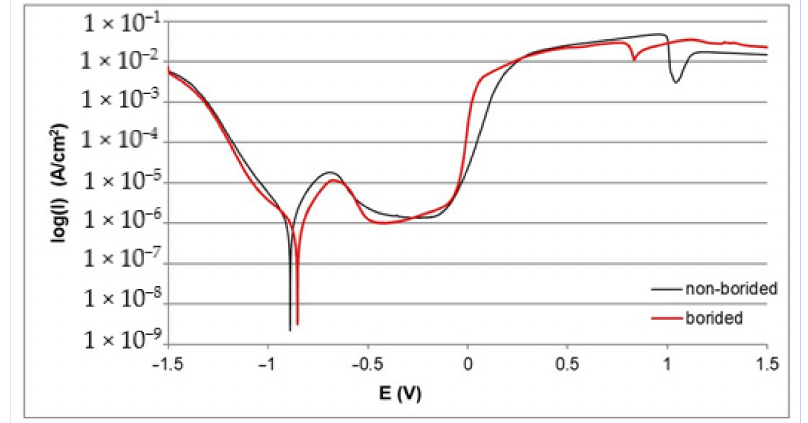
Figure 4. Polarization curves recorded during the corrosion resistance test in a 3.5% NaCl solution for borided and non-borided Nickel 201.